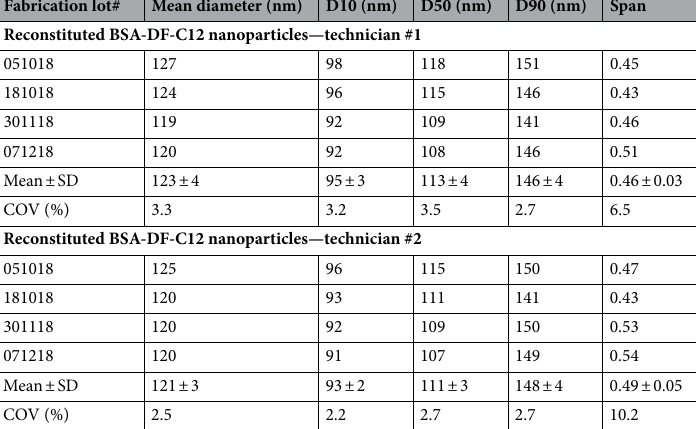
Fabrication lot#